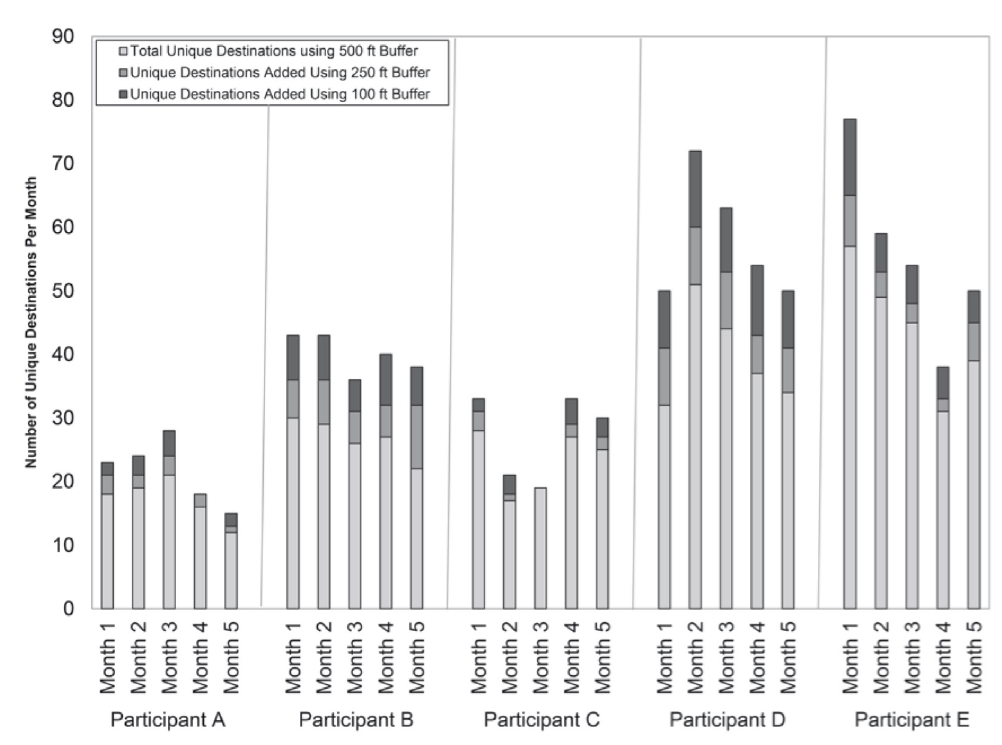
Figure 8. Counts of unique destinations for 5